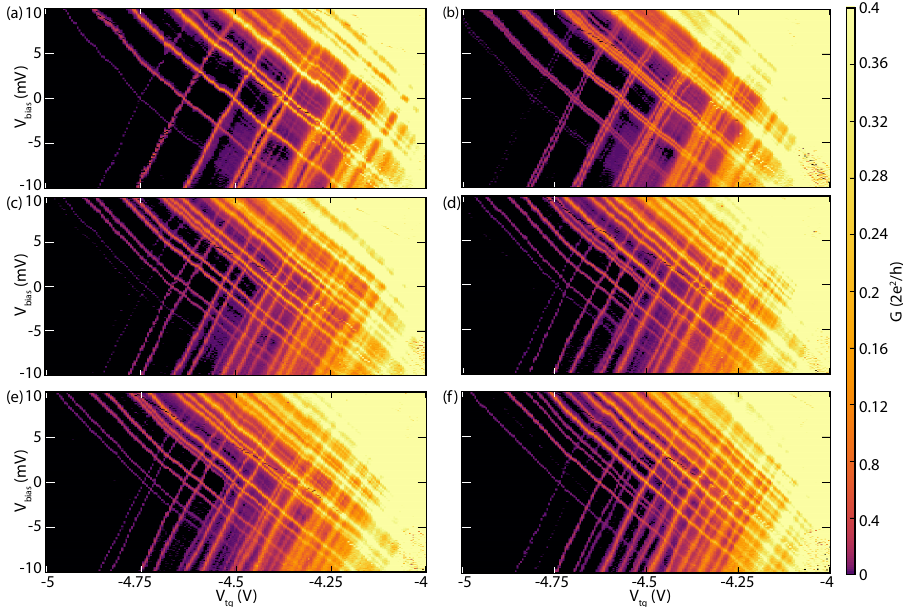
Figure S3: Additional data for Figure 2 from device 1. Global backgate voltage = -15V. (a) 0T, (b) 0.34T (c) 1T (d) 2.2T (e)2.6T (f)4.0T. Magnetic field is pointing at a 25 degree angle relative to the nanowire